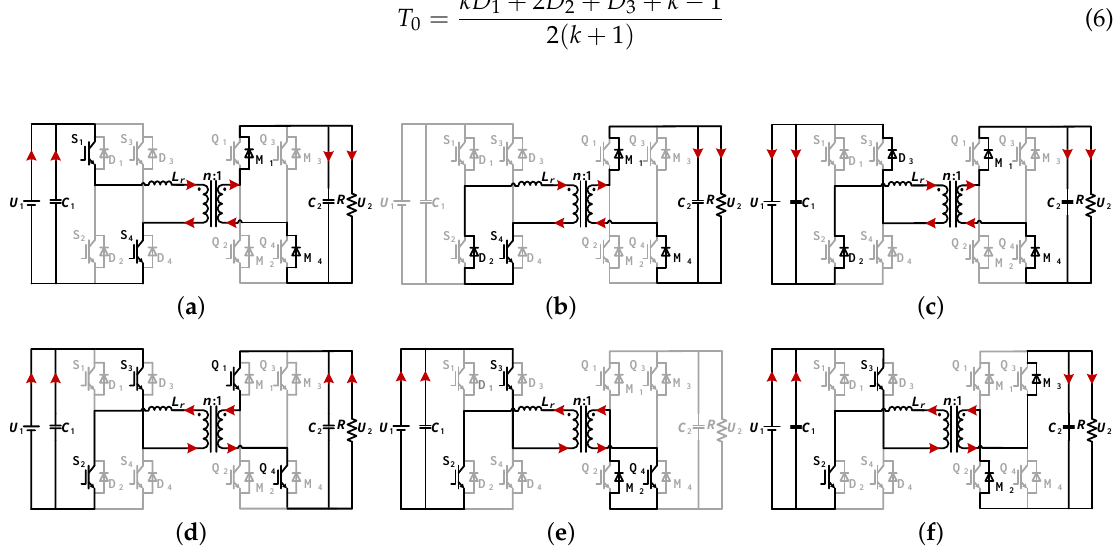
Figure 7. Operating states under M I : ( a ) State 1; ( b ) State 2; ( c ) State 3; ( d ) State 4; ( e ) State 5; and ( f ) State